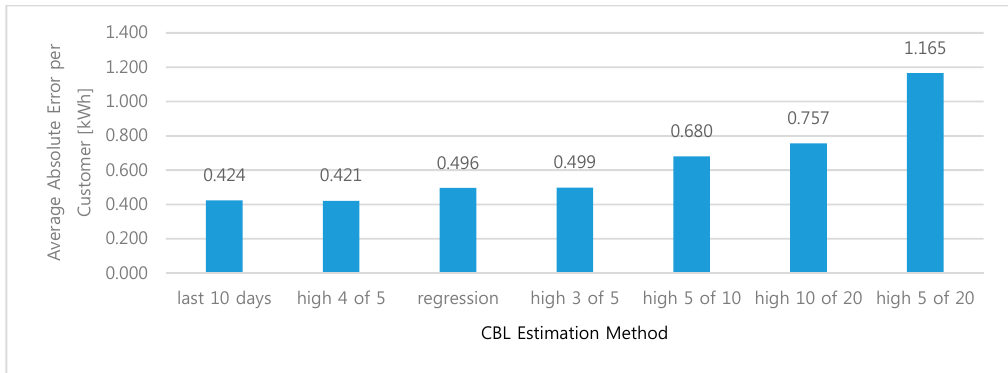
Figure 8. Average sum of absolute error for an individual customer for different CBL methods.